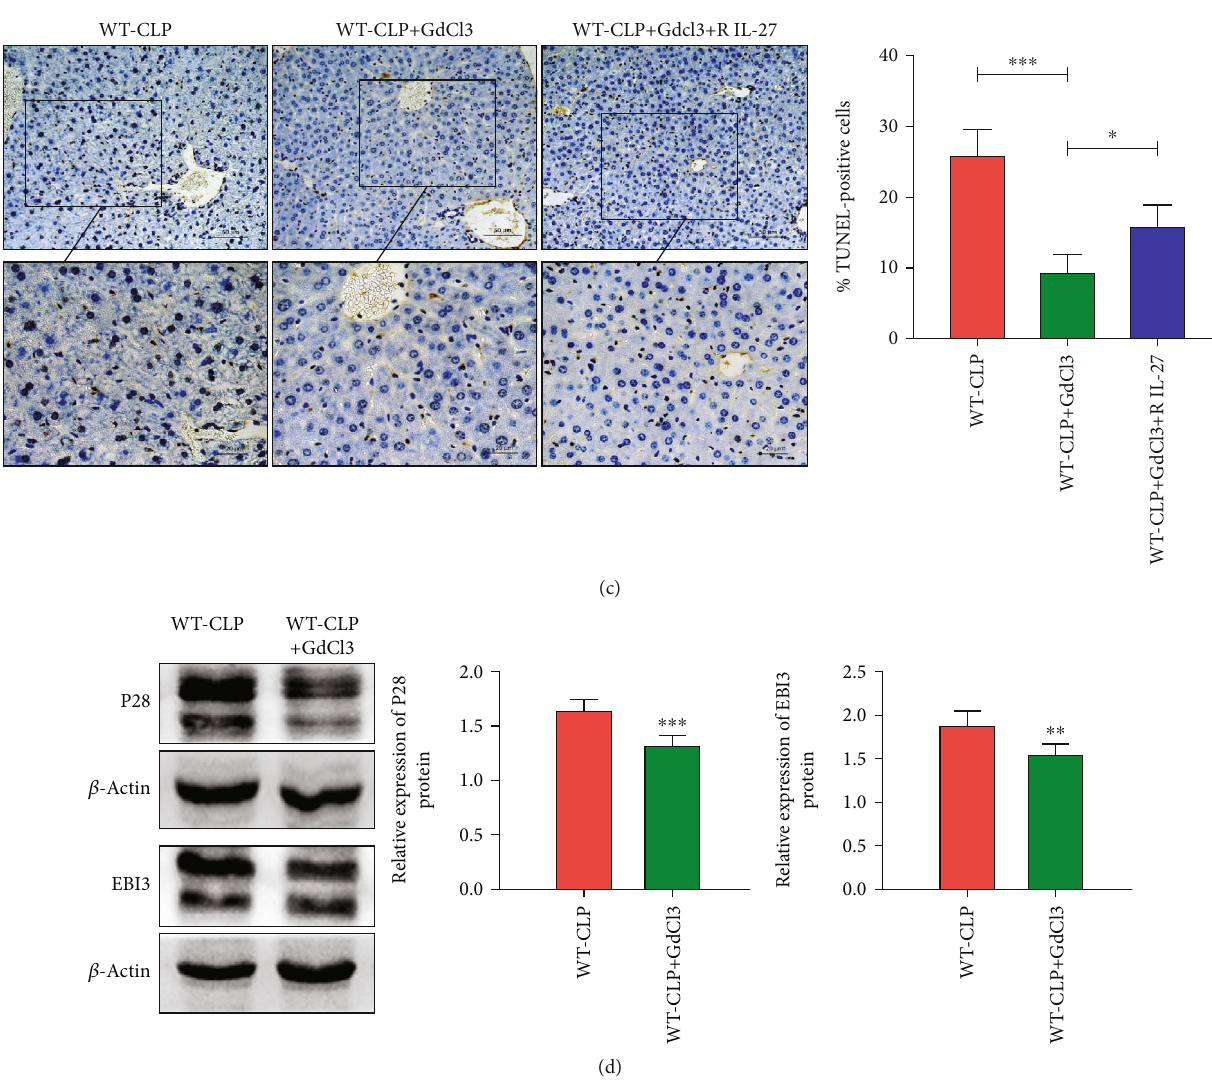
Figure 2: (a) Hematoxylin and eosin- (H&E-) stained liver tissues and histological scores for liver from WT mice ( n = 5 per group) with or without GdCl3 and recombinant IL-27 (R IL-27) pretreatment (sham and after CLP), ∗ p < 0 : 05 , ∗∗ p < 0 : 01 , ∗∗∗ p < 0 : 001 , NS: p > 0 : 05 . (b) Serum ALT and AST levels of WT mice after CLP with or without GdCl3 and recombinant IL-27 (R IL-27) pretreatment, ∗ p < 0 : 05 , ∗∗ p < 0 : 01 , ∗∗∗ p < 0 : 001 . (c) DNA fragmentation analysis (TUNEL) and TUNEL-positive cell proportion of the liver from WT mice ( n = 5 per group) after CLP with or without GdCl3 and recombinant IL-27 (R IL-27) pretreatment ( × 200, × 400 magni fi cations), ∗ p < 0 : 05 , ∗∗ p < 0 : 01 . (d) EBI3 and P28 protein levels in the liver tissue of WT mice after CLP with or without GdCl3 pretreatment. ∗∗ p < 0 : 01 , ∗∗∗ p < 0 : 001